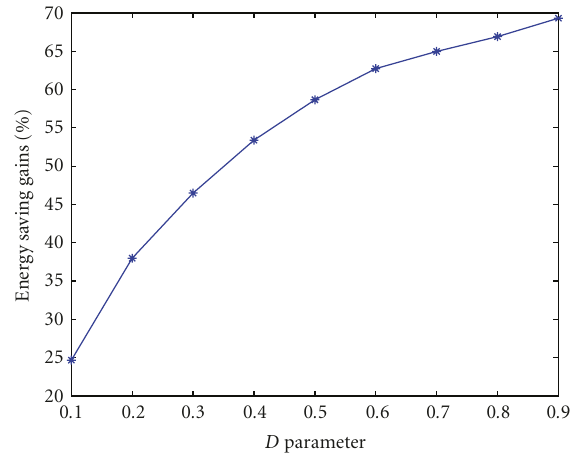
Figure 3: Performance improvement for di ff erent D parameters under a 11 hops route with delay constraint T = 0 . 3 and target BER = 10 − 3 .